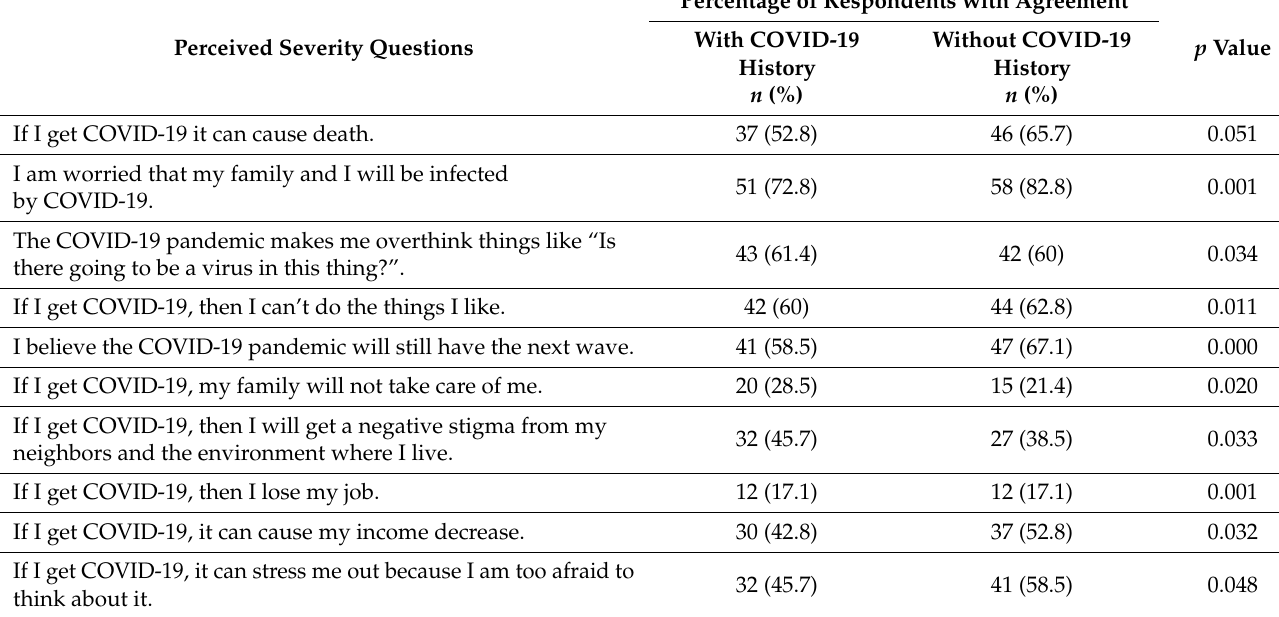
Table 3. Perceived severity